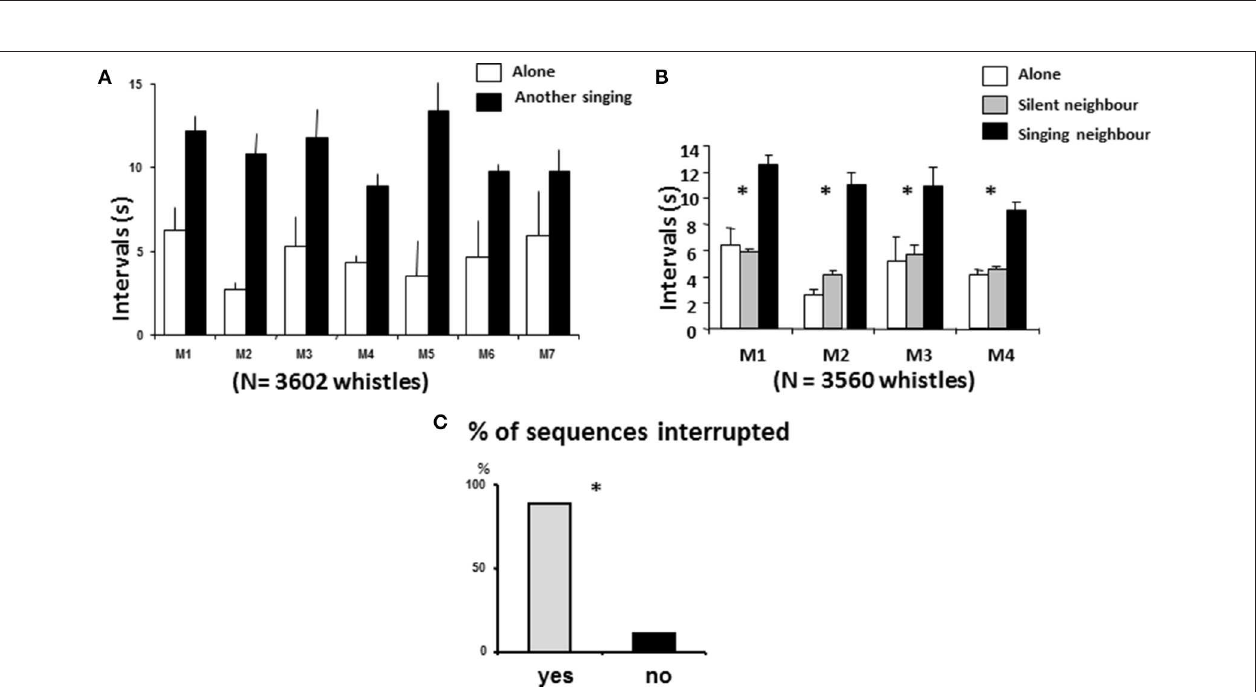
FIGURE 6 | Song behavior according to immediate context. (A) Males increased their interval duration when another bird was singing (Wilcoxon, N = 7 , T = 0 , p < 0.02 ). (B) Birds did not change their interval duration when another bird was present but silent and increased their interval duration when the other bird was singing. (C) Most of the birds interrupted the vocal interaction in case of overlap ( * : X 2 = 2256 , df = 1 , p ≤ 0